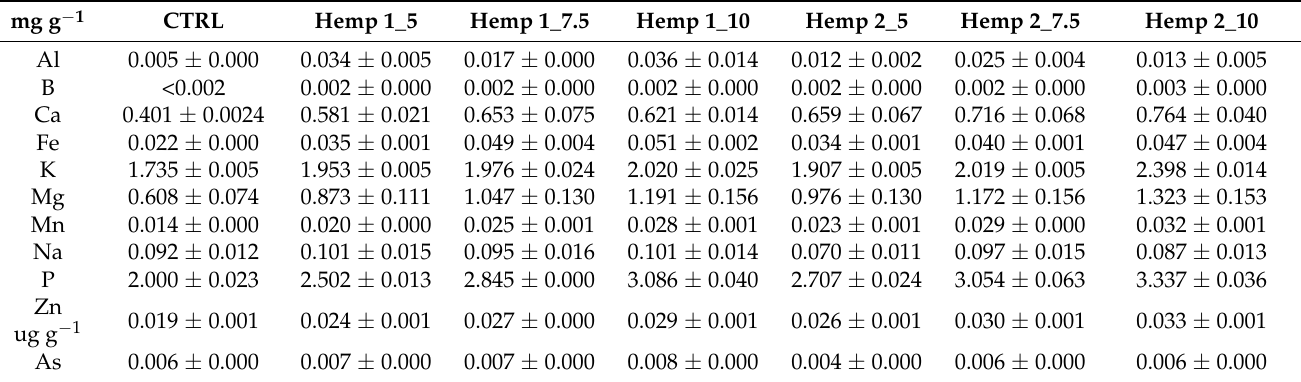
Table 8. Mineral content in cooked, fortified